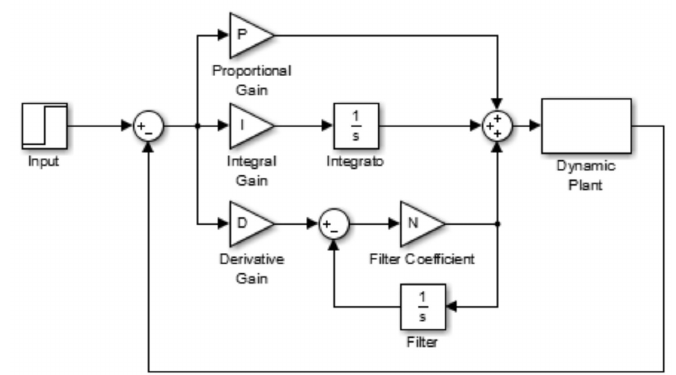
Figure 3. A schematic of the PID control scheme.